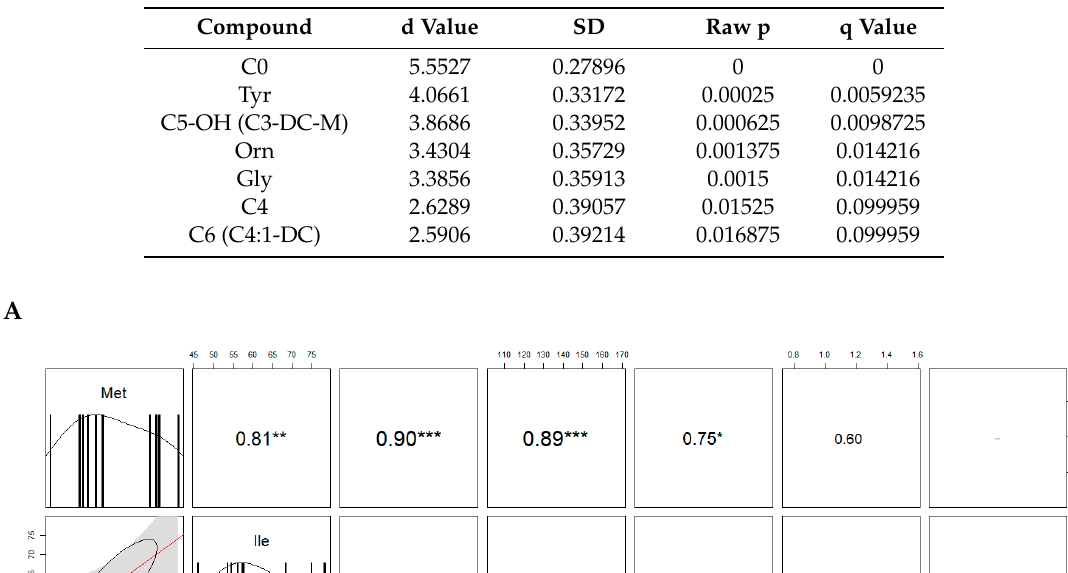
Important features identified by significance analysis of metabolites (SAM): Butyrylcarnitine / Isobutyrylcarnitine (C4), carnitine (free) (C0), glycine (Gly), hexanoylcarnitine (C6)